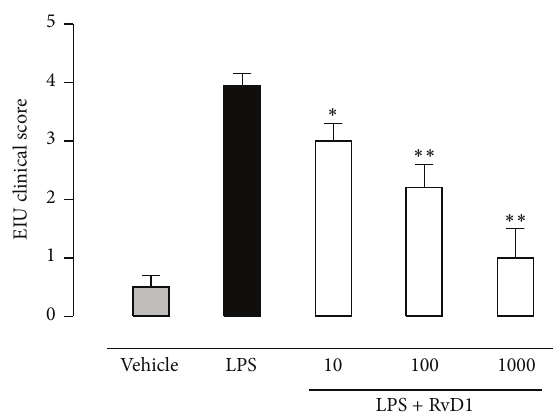
Figure 1: Intravitreal Resolvin D1 (RvD1) improves the clinical score in rats with EIU. The rats were treated with vehicle (saline+ethanol), LPS (200 𝜇 g/rat), and LPS+RvD1 at the dose of 10-100-1000ng/kg 1h post-LPS treatment and were evaluated 24 h after injections. Clinical manifestations of EIU were graded as reported in test (see Section 2). Values are reported as the mean ± SEM, of 𝑛 = 6 observation for each experimental group. ∗ 𝑃 < 0.05 and ∗∗ 𝑃 < 0.01 compared with LPS-treated group.